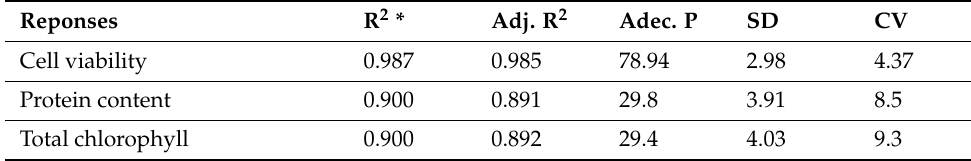
Table 2. Statistical analysis results for response parameters for S. obliquus . Reponses R 2 * Cell viability